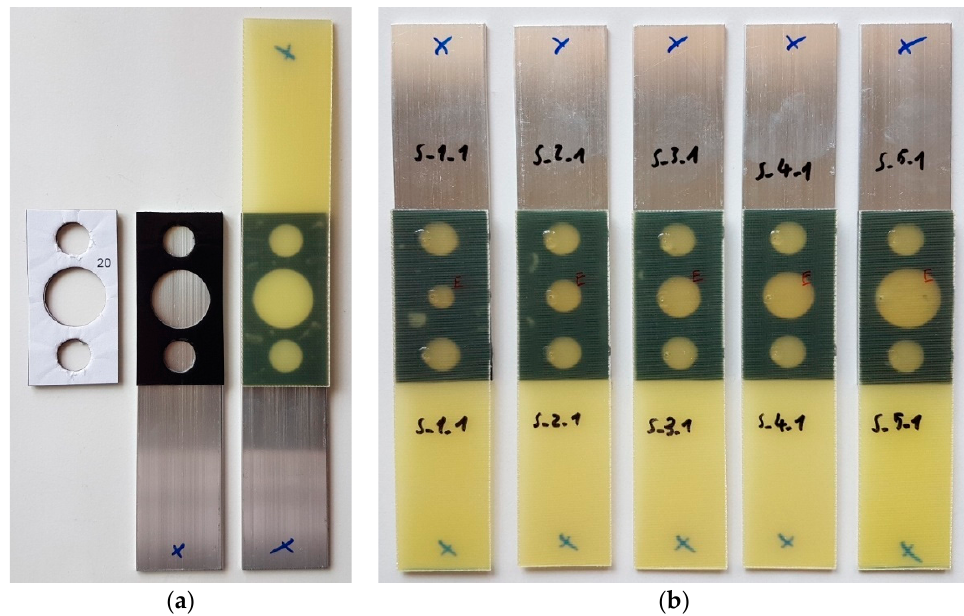
Figure 4. Triple-adhesive samples: ( a ) stages of fabrication; ( b ) completed samples. The samples were cured at room temperature for one week. After this time, they were subjected to static uniaxial tensile tests on an MTS 100 kN testing machine. Ac- cording to ASTM D1002-10(2019), the loading rate was 1.27 mm/min. The results from the testing machine were processed in the Diadem software (2019). An Aramis digital image correlation (DIC) system was used to observe strains on the surfaces of the laps. The results from the Aramis system were processing in the GOM Correlate software (2020). 3. Results and Discussion The research was divided into two stages, and 50 lap specimens were tested in each stage. In the first stage of testing, the behavior of 10 batches of dual-adhesive joints was determined to identify the two extreme types of joints, taking into account their stiffness. In the second stage of testing, the behavior of 10 batches of joints differing in both the geometry and location of stiff and elastic joints was determined. The DIC system was also used to observe deformations in this stage. 3.1. Results for the First Stage of the Study Dual-adhesive specimens with one epoxy bond and a double-sided adhesive tape were used in the first stage of the work. These are materials that differ in both shear strength and stiffness. The failure of this type of joint proceeds in two stages. First, the rigid epoxy joint is damaged. This process occurs quite quickly for displacement in the range of 0.2–1 mm. In the next stage, the double-sided adhesive tape begins to work, which is damaged over a relatively long displacement, as can be seen in the graph in Figure 5b. However, for this part of the study, the first stage of the work and the com- parison of 10 epoxy adhesives are the most interesting parts.